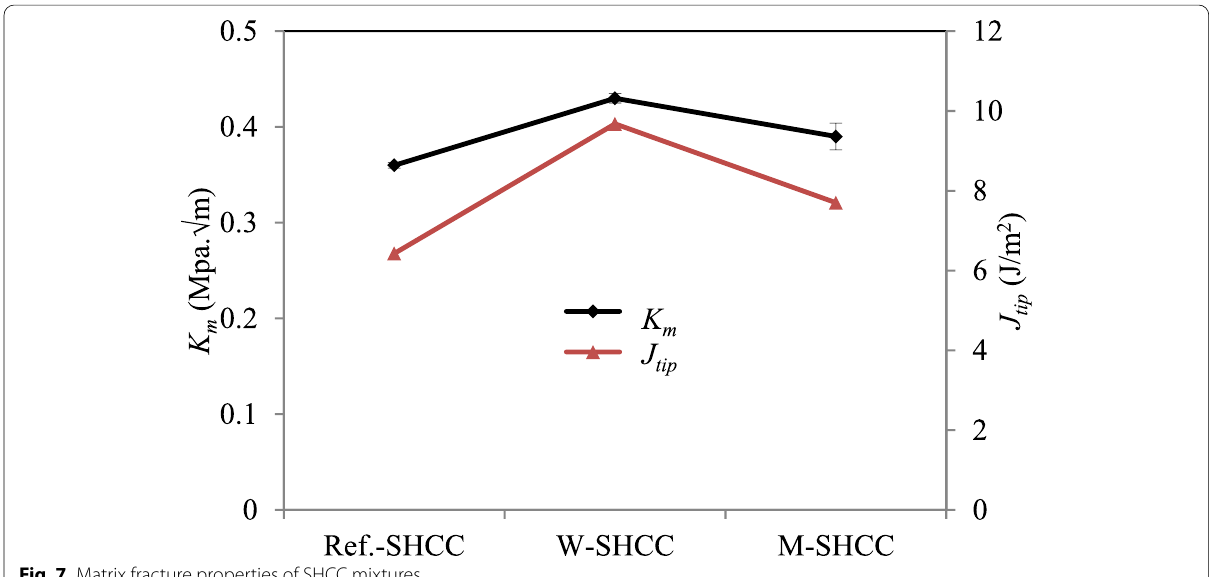
Fig. 7 Matrix fracture properties of SHCC